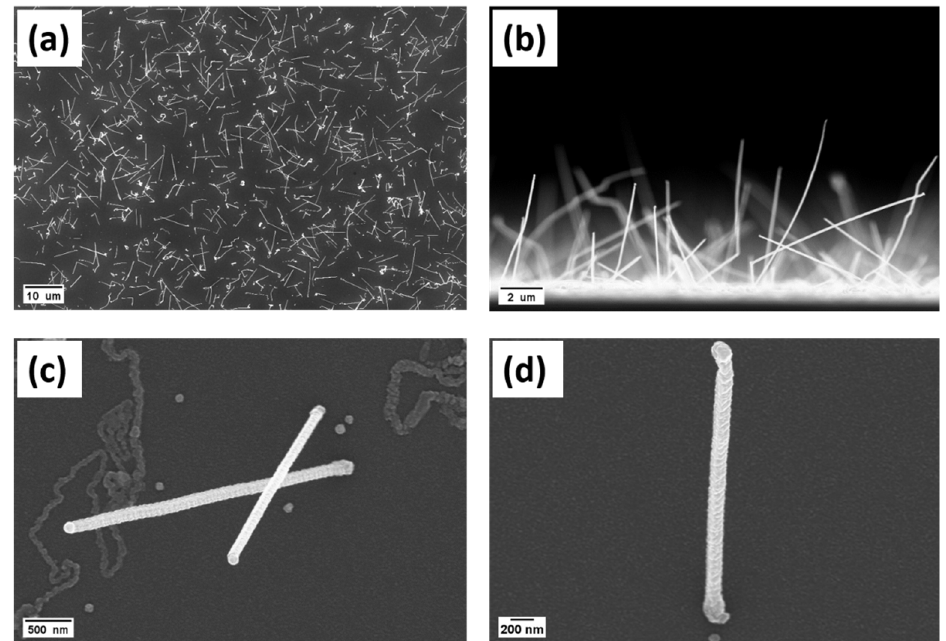
Figure 1. SEM images in ( a ) plan and ( b ) cross-section view of GeTe NW core, and ( c , d ) plan view of GeTe/Sb 2 Te 3 core–shell NWs grown on Si (100) with 50 nm Au NPs at different magnifications. The growth durations were 60 and 90 min for the GeTe core and Sb 2 Te 3 shell, respectively.